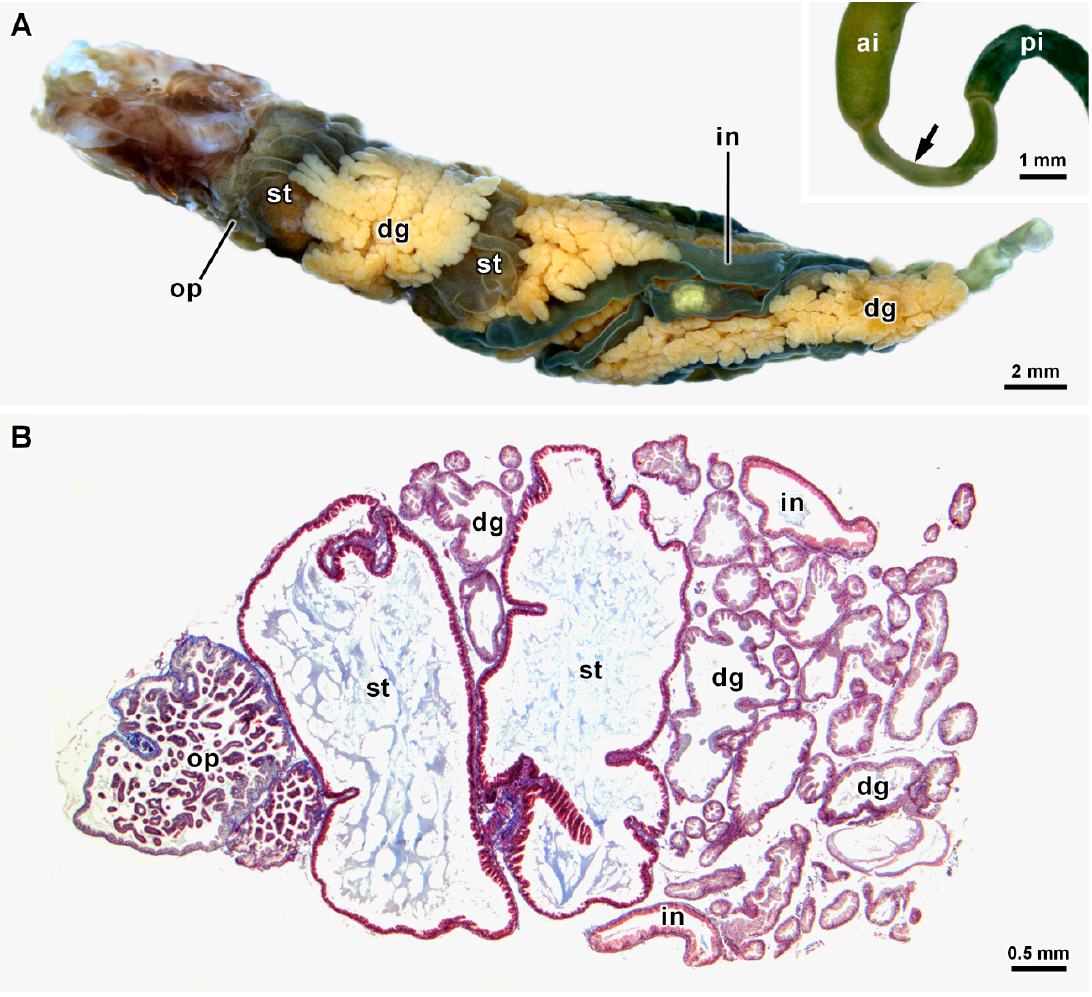
Figure 1. General view of the digestive system. ( A ) Stereomicroscope view of the digestive system of A. fascicularis . Inset, narrow segment (arrow) corresponding to the valve between the anterior (ai) and posterior intestine (pi). ( B ) Histological section of the digestive system of C. angulata stained